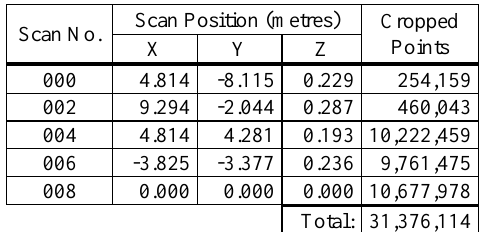
Table 1. Scan positions and number of points in E57 benchmark The scans were processed in Faro Scene 5.1 and a cropped section of the corridor exported as an E57 from CloudCompare (Girardeau-Montaut, 2012) with the extents illustrated in Figure 5. This means the cropped section includes a wall thickness to the adjoining lecture theatre in which scans 000 and 002 were captured. The pointclouds have had no further cleaning and so still contain the tripod setup positions of the total station.